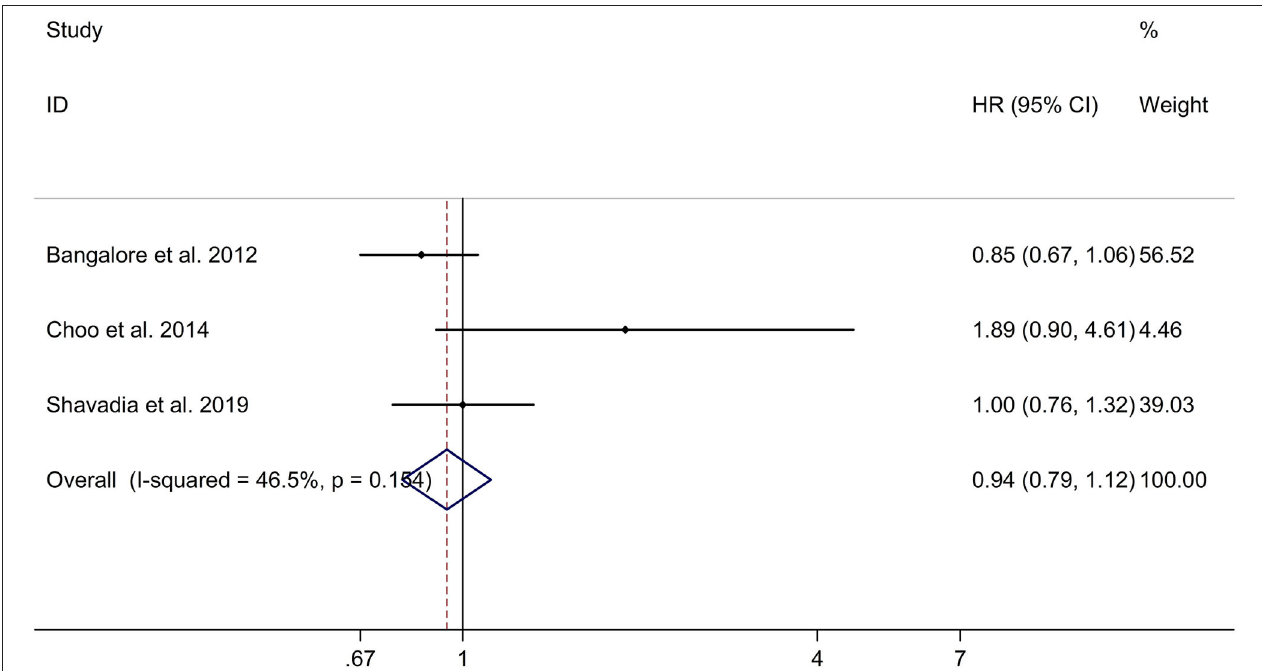
FIGURE 6 | Forest plots exploring the long-term effect of β - blocker use on risk of stroke in patients after MI. CIs, confidence intervals; HRs, hazard ratios; MI, myocardial infarction.